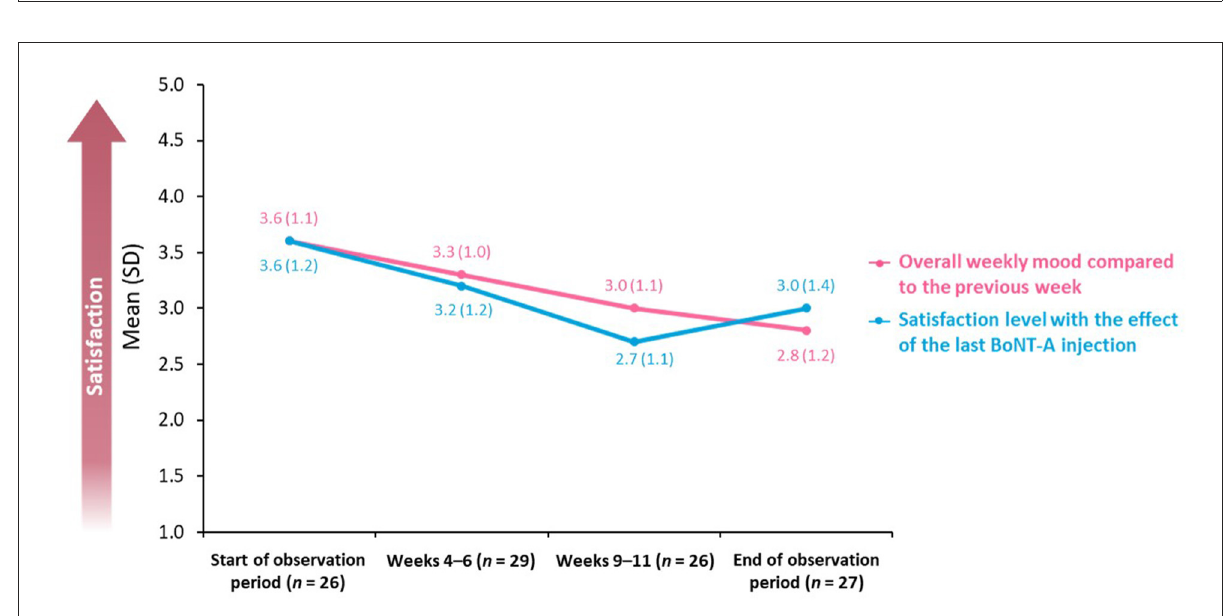
FIGURE4 Overall weekly mood and BoNT-A treatment satisfaction. BoNT-A, botulinum neurotoxin A; SD, standard